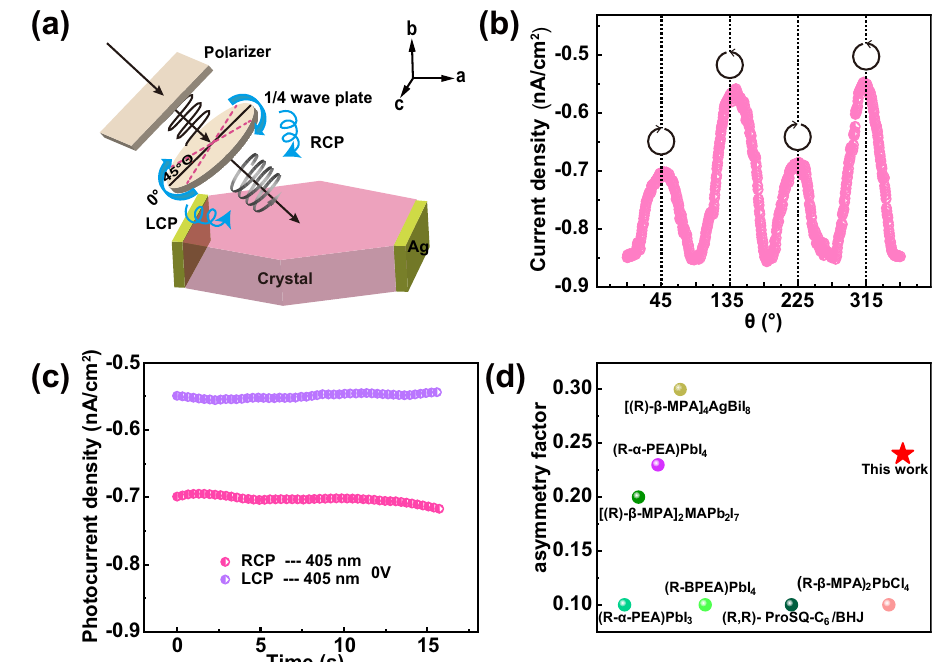
Fig.5|Circularpolarizationlight-dependentbulkphotovoltaiceffect(CBPE)in ABI. a The schematic view of the testing the CBPE device. b Photocurrent density versusthelinearpolarizationangleastunedbythe λ /4plateundertheillumination of 119.20mW/cm 2 .Blackarrowsindicateright-and left-handed circularlypolarized